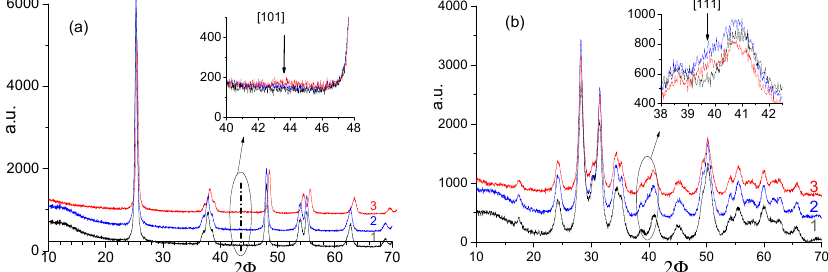
Figure 10. DRX patterns of support (1) for Ru / TiO 2 ( a ) and Pt / ZrO 2 ( b ) before (2) and after (3) oxidation of sugarcane